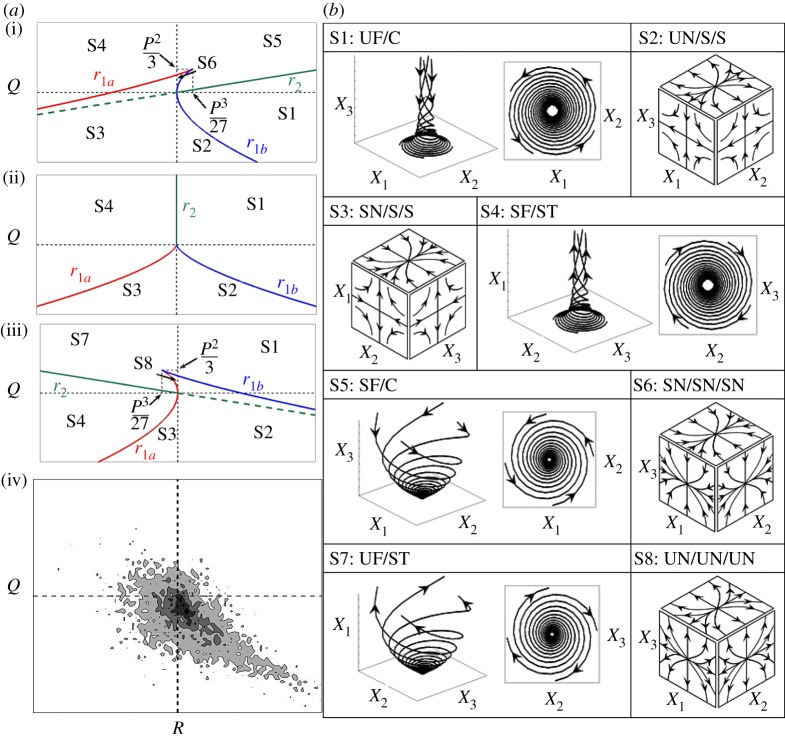
(a) Classification of the S1–S8 topologies in the Q−R plane for (i--iii) P > 0, P = 0 and P < 0, and (iv) the ‘teardrop’-shaped PDF(R,Q) lying in the P = 0 plane. The lines r1a (red), r1b (blue) and r2 (green) dividing the topologies are shown. Black dashed lines correspond to Q = 0 and R = 0. (b) Classification of the S1–S8 topologies: UF, unstable focus; UN, unstable node; SF, stable focus; SN, stable node; S, saddle; C, compressing; ST, stretching. (Reproduced with permission from Wacks & Chakraborty [23].)